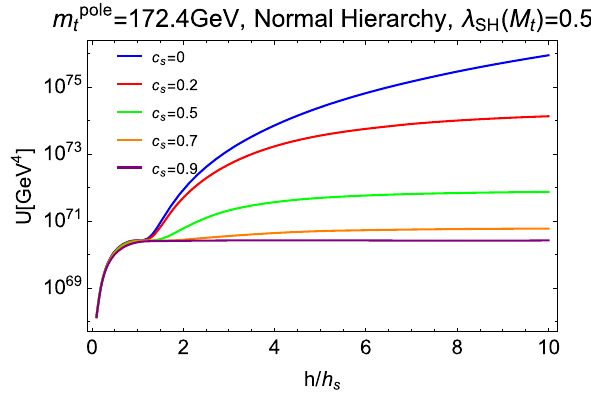
Fig. 5 The Higgs potential in the Einstein frame